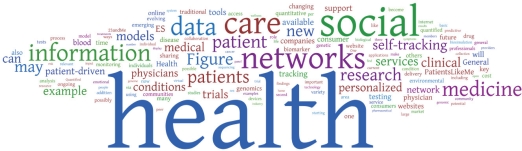
Many Eyes data visualization of this paper.